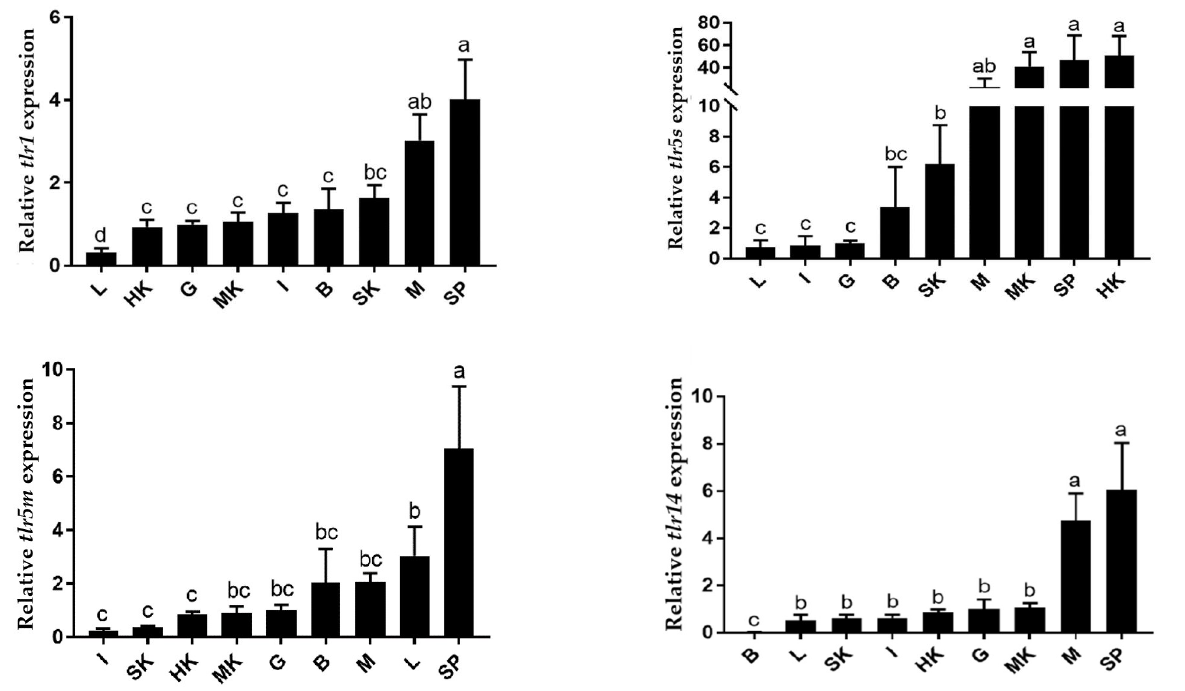
Figure 8. The expression of swamp eel toll like receptor (TLR) genes in various tissues (setting the expression level of the TLRs in the gonads to 1). Each value represents mean ± SD ( n = 3), and bars with different letters indicate significantly differences by LSD test for each time point ( p < 0.05). Note: